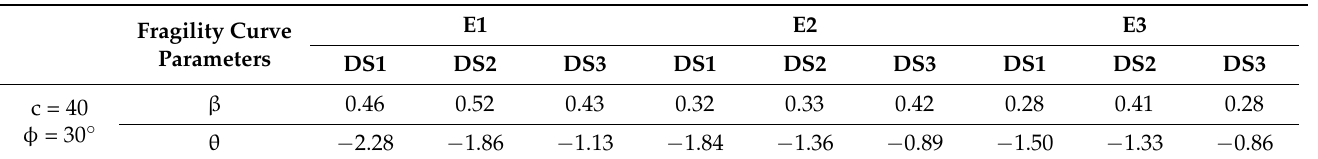
Table 5. Fragility curve parameters for different damage limit states due to all records with ϕ = 30° and c = 40 kPa.